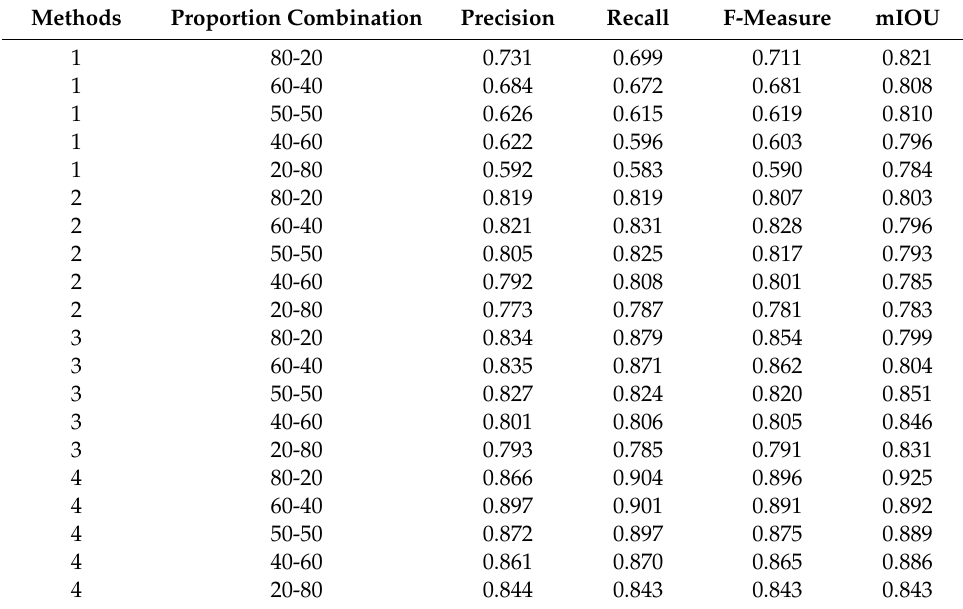
Figure 3. Ground truth versus estimated number of panicles per plot. ( a ) represents the correlation between the ground truth and improved R-FCN, ( b ) represents the correlation between the ground truth and AlexNet, ( c ) represents the correlation between the ground truth and VggNet and ( d ) represents the correlation between the ground truth and Inception-V3. The vertical axis refers to the number of panicles estimated by the proposed approach and the horizontal axis refers to the number of panicles that have been manually counted. Table 4. Evaluation and validation of panicle detection using different models applied to UAV image dataset. ‘1’ represents AlexNet, ‘2’ represents VggNet, ‘3’ represents Inception-V3, and ‘4’ represents improved R-FCN.